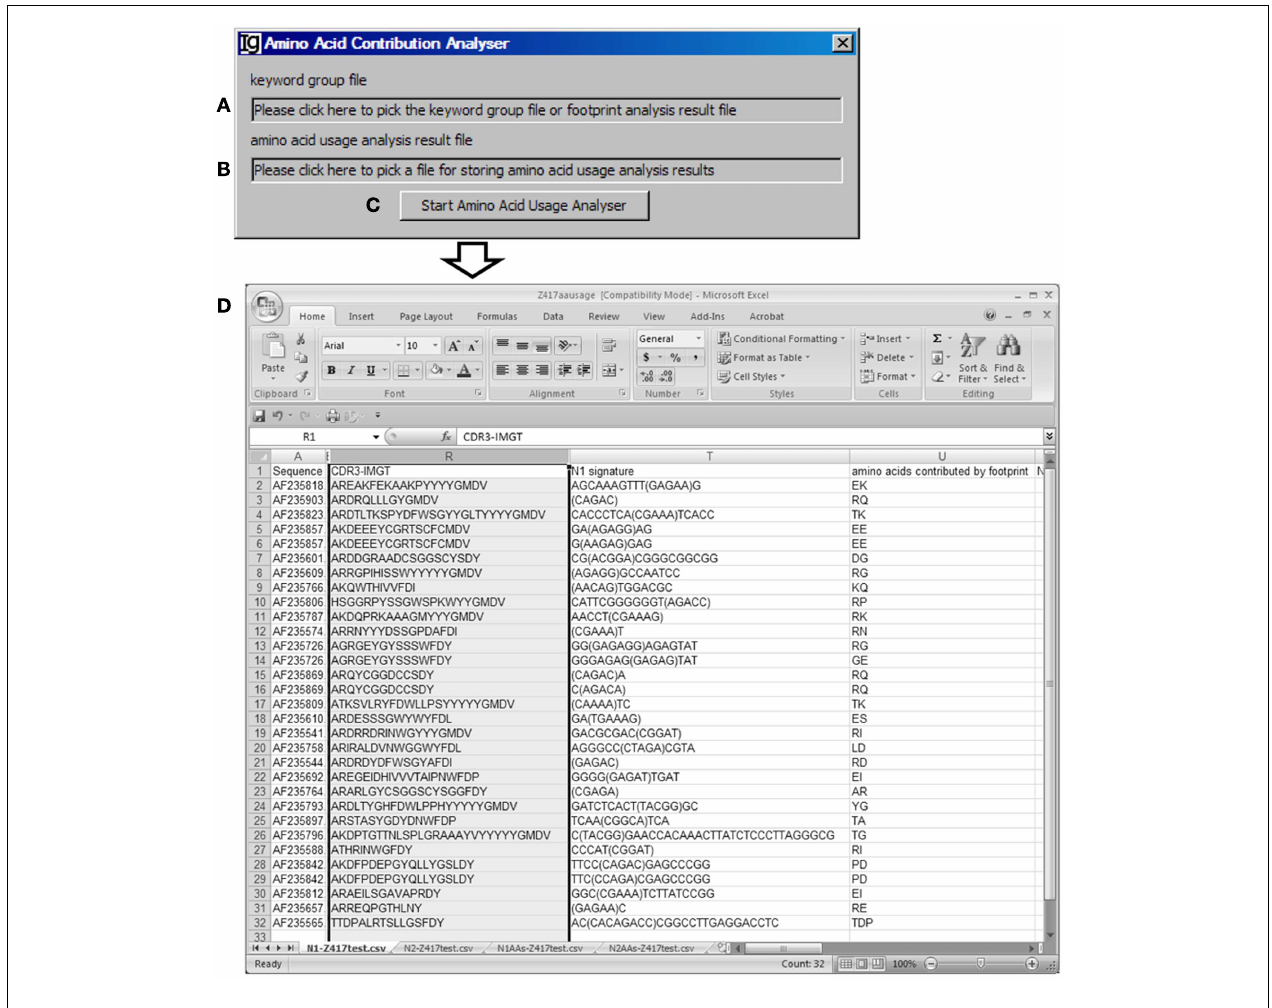
FIGURE 8 |The amino acid contribution analyzer . Diagram shows the interface of the Amino Acid Contribution Analyzer. (A) Textbox for selecting the footprint analysis result file. (B) Textbox for selecting the output